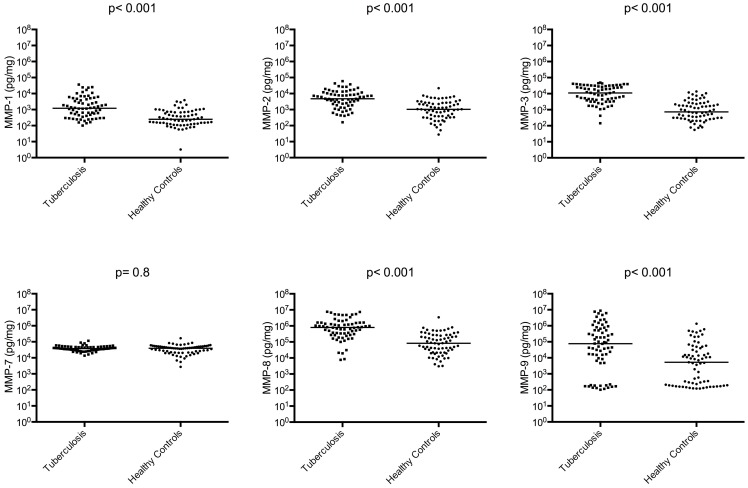
Multiple MMP concentrations are increased in induced sputum from TB patients.MMP-1, MMP-2, MMP-3, MMP-8, MMP-9 concentrations are significantly increased among TB patients compared to healthy controls analysed at time of TB diagnosis. The horizontal line is the median value.